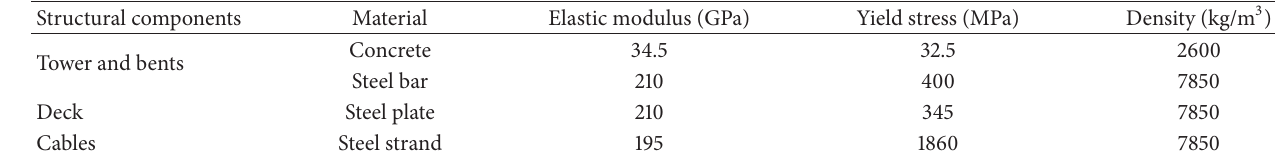
Table 1: Material properties of Puqian Bridge.